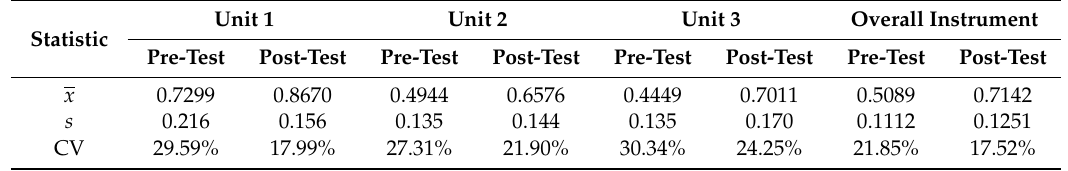
Table 2. Test execution scores by type of administration and